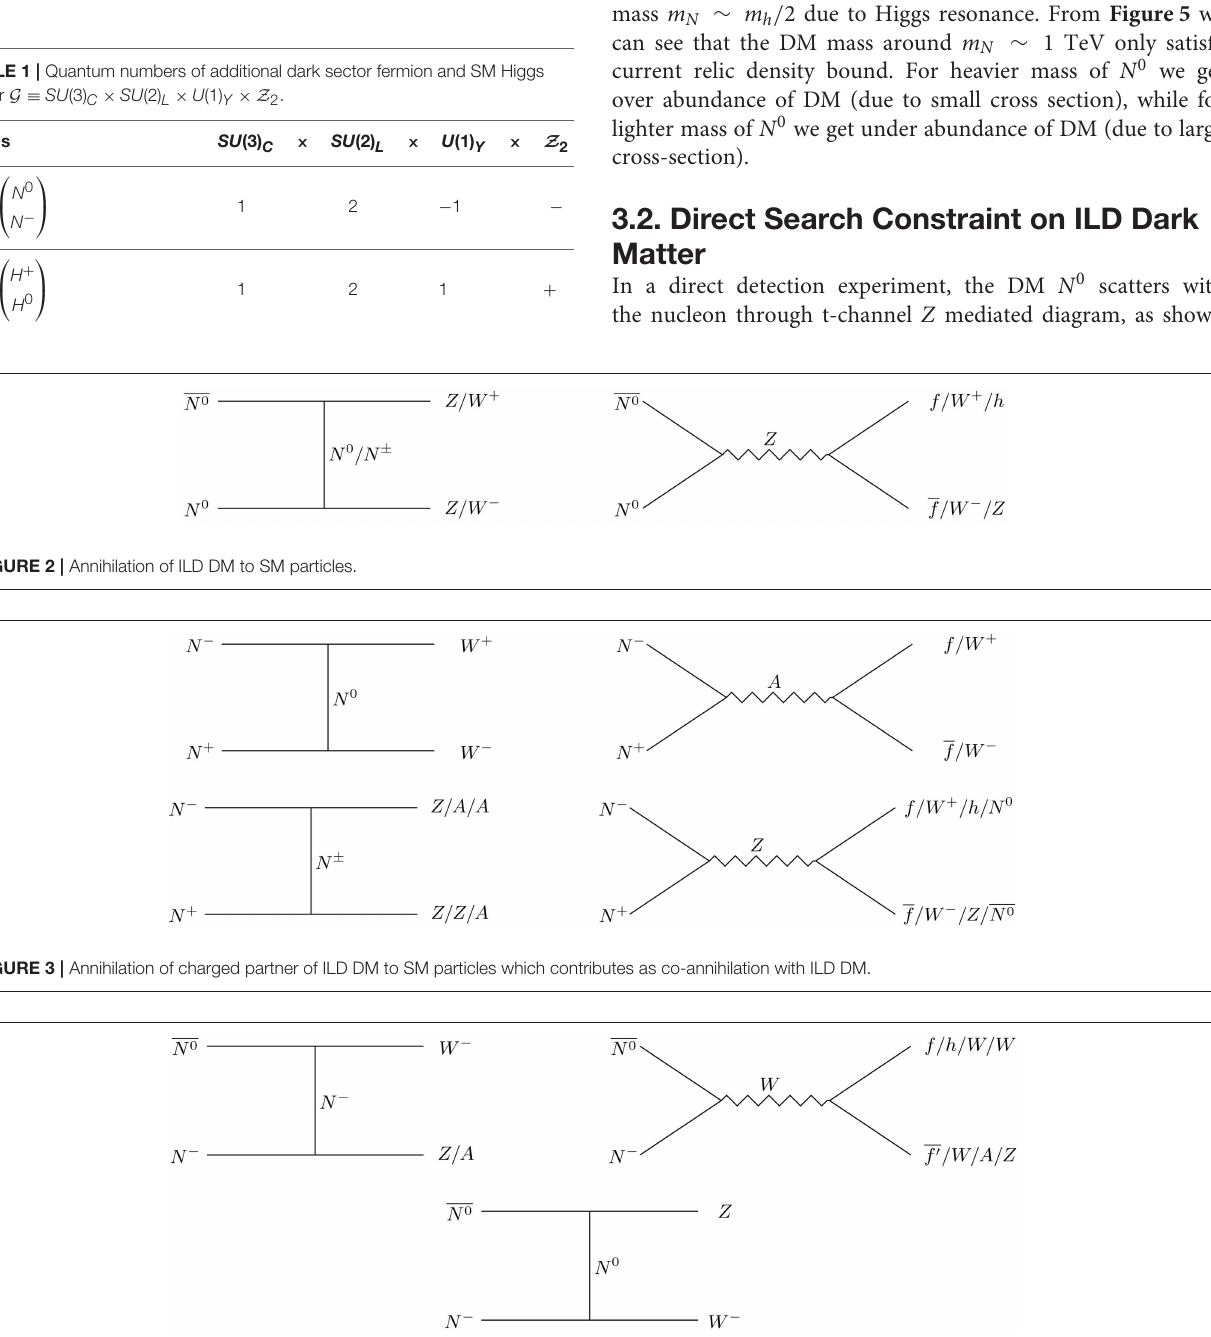
FIGURE 4 | Co-annihilation processes of DM N 0 with its charged partner N ± to SM particles.